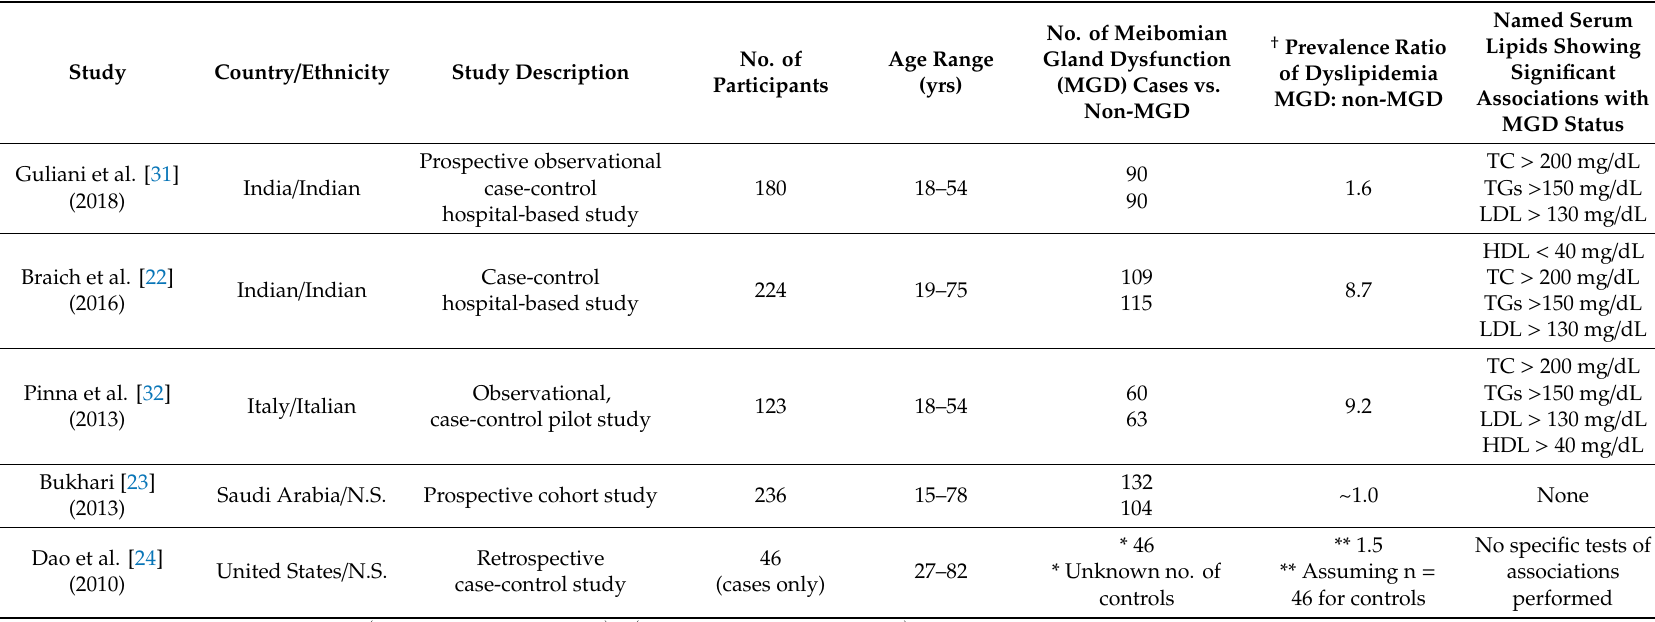
Table 1. Summary of information from the included